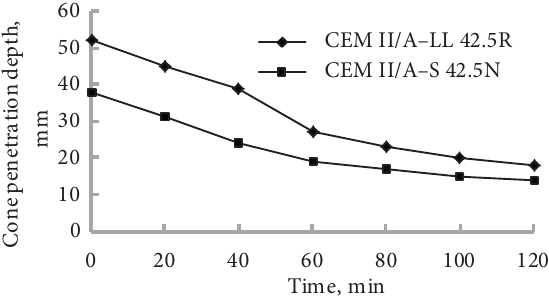
Table 8. The yield stress of concrete mixtures with